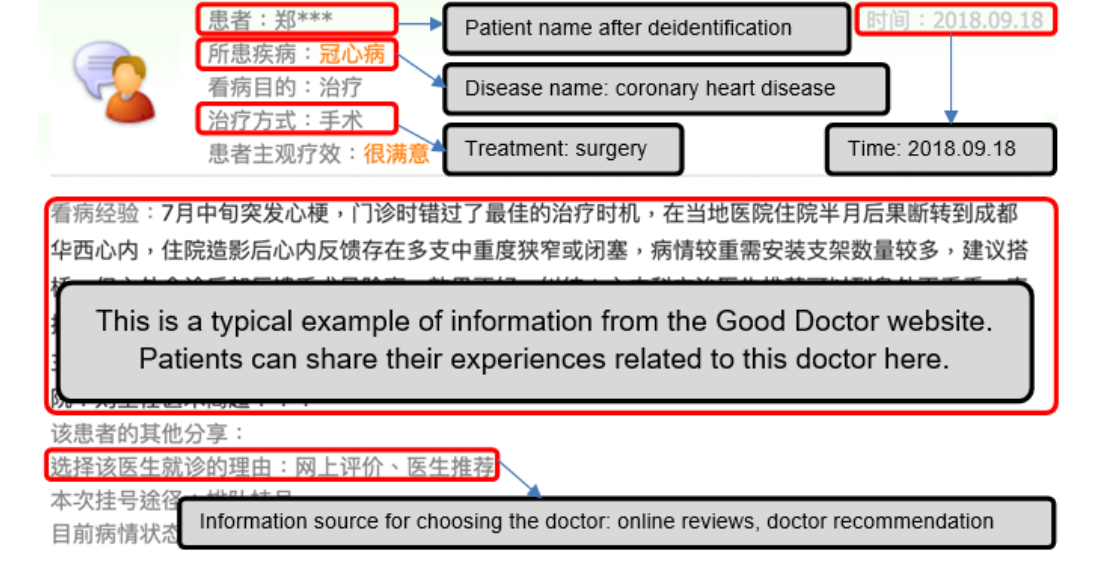
Figure 2. The sample collection process and